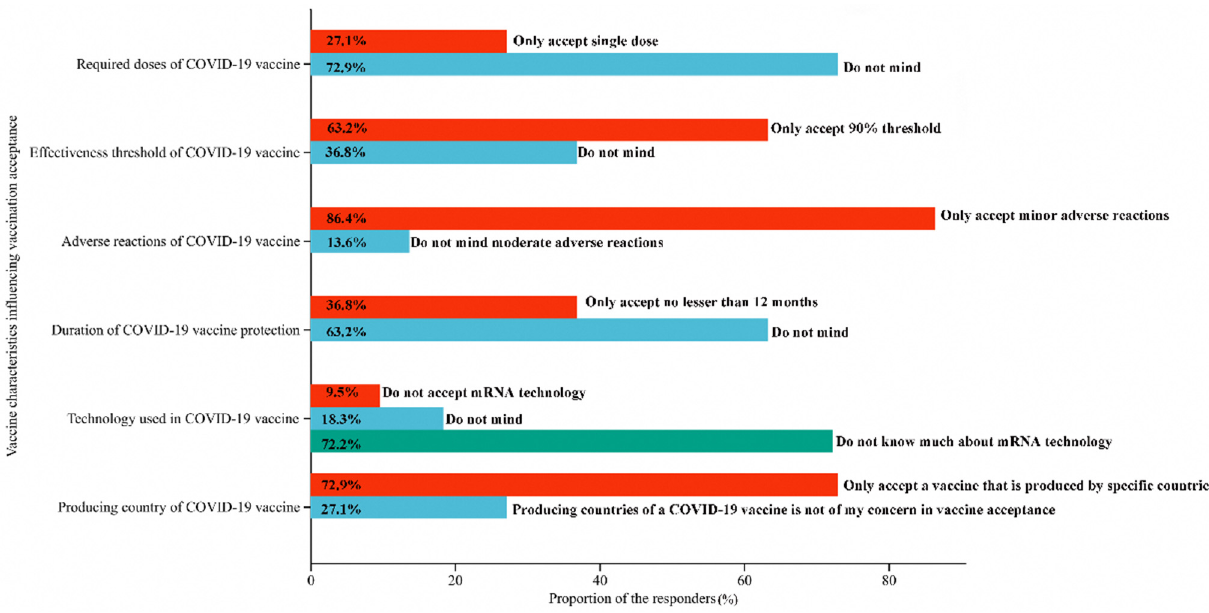
Figure 2. The choice of vaccine characteristics influencing vaccination acceptance ( N = 1037).